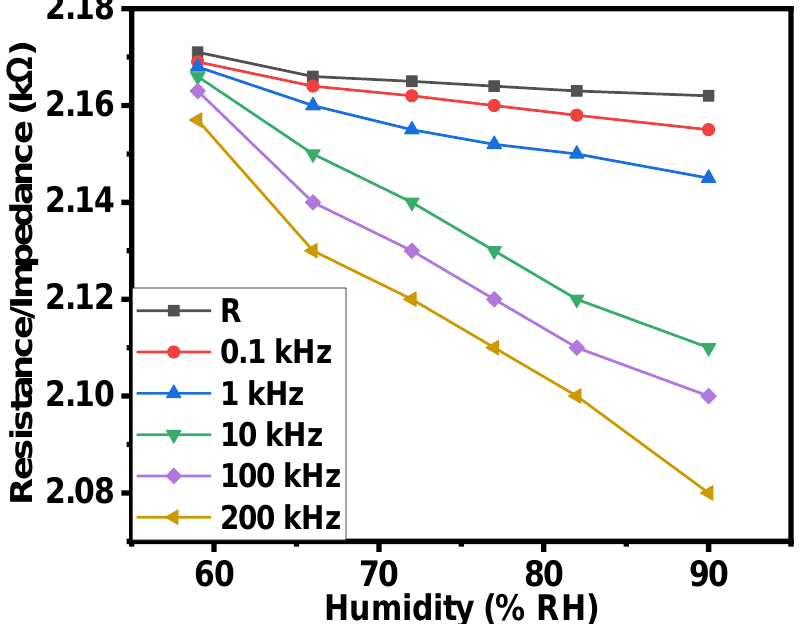
Figure 5. Resistance/impedance – humidity relationships of the surface-type shockproof resistor based on NiPc – oil jelly and CNT – oil jelly – rubber composite.